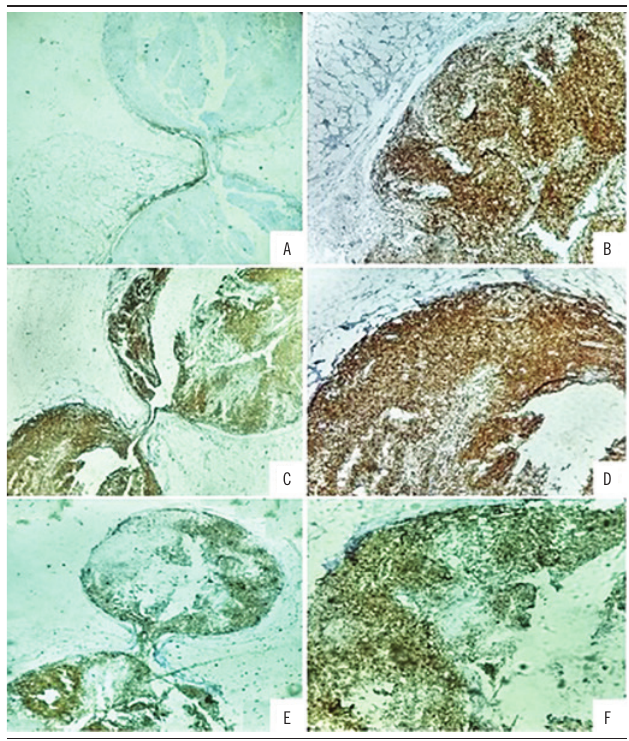
FIGure 3 – Immunohistochemistry to exclude a diagnosis of follicular lymphoma A) CD10 (-) identifies lymphoid progenitor cells, germinal cells in lymphoid tissues, and immature B cells; B) Bcl-2 (+) is an antiapoptotic marker and is highly expressed in follicular lymphomas; C and D) CD3 (+) is a T-cell surface glycoprotein; E and F) CD20 (+) quantitatively identifies B